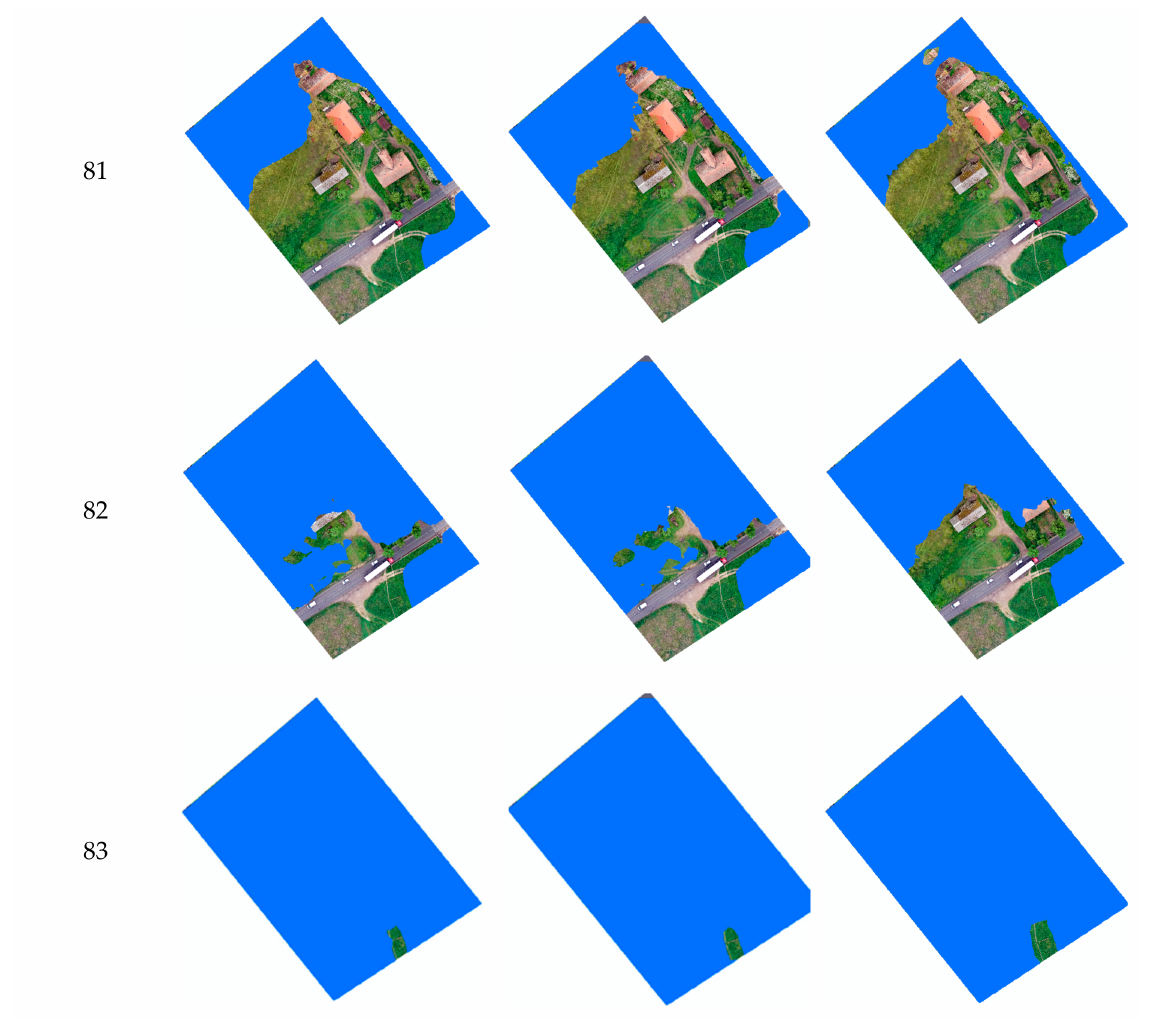
Figure 5. Visual comparison of detected inundation area based on the water level and true, LiDAR, and UAV data.